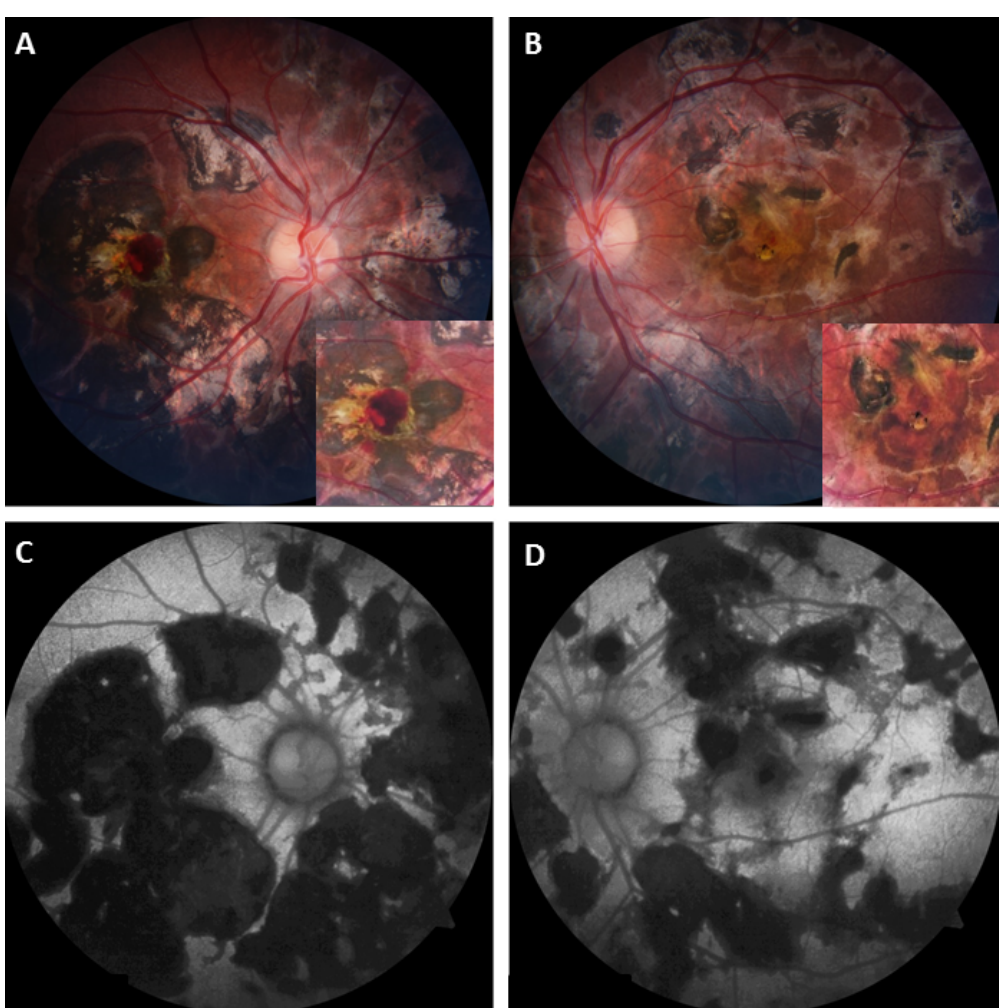
Figure 1: Fundus photo of the right eye (A) and the left eye (B) at presentation showing multiple pigmented healed choroiditis patches of variable size at the posterior pole. A small retinal haemorrhage adjacent to yellowish membranous lesion (inset; A) and a suspicious yellowish membranous lesion (inset; B) was also noted. Fundus autofluorescence of the right eye (C) and the left eye (D) at presentation showing uniform hypoautofluorescence over the choroiditis lesions suggestive of healed